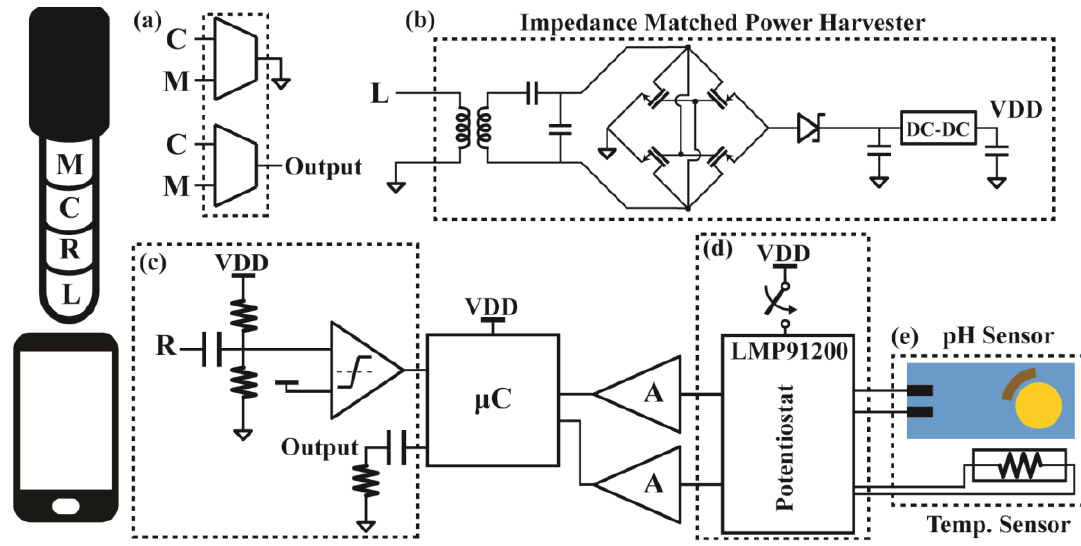
Figure 2. Block diagram of the electronic pH module that communicates with the smartphone and interfaces with the sensors. The module contains: ( a ) multiplexers to select the correct pins to connect to the common and microphone ports, ( b ) an impedance matched power harvester that rectifies and transforms a signal from the left audio output to power the entire module, ( c ) bidirectional AC coupled communication with the smartphone that sends back the gathered data, a ( d ) readout and signal conditioning circuitry, and ( e ) pH and temperature sensors.